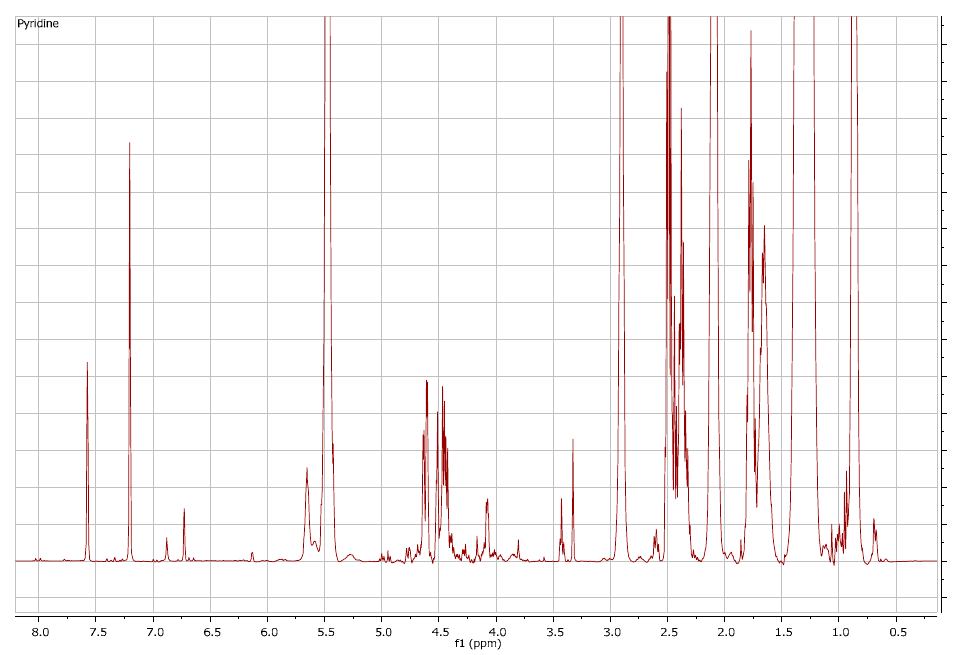
Figure A4 . NMR spectrum of flour extract in Pyridine-d5 Figure A4. NMR spectrum of flour extract in